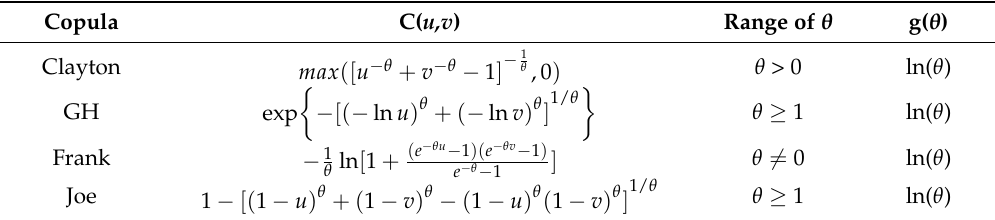
Table 2. The description of the Archimedean copulas and their link functions.